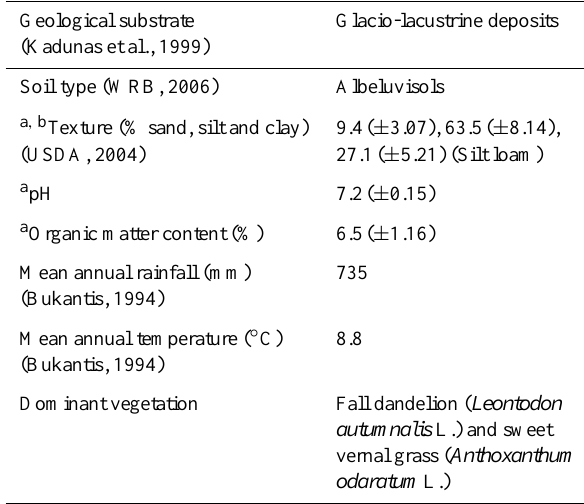
Table 1. Main characteristics of the study area. Table 2. WDPT classes used in this work. Water drop penetration time measured in seconds (s) (according to Doerr,